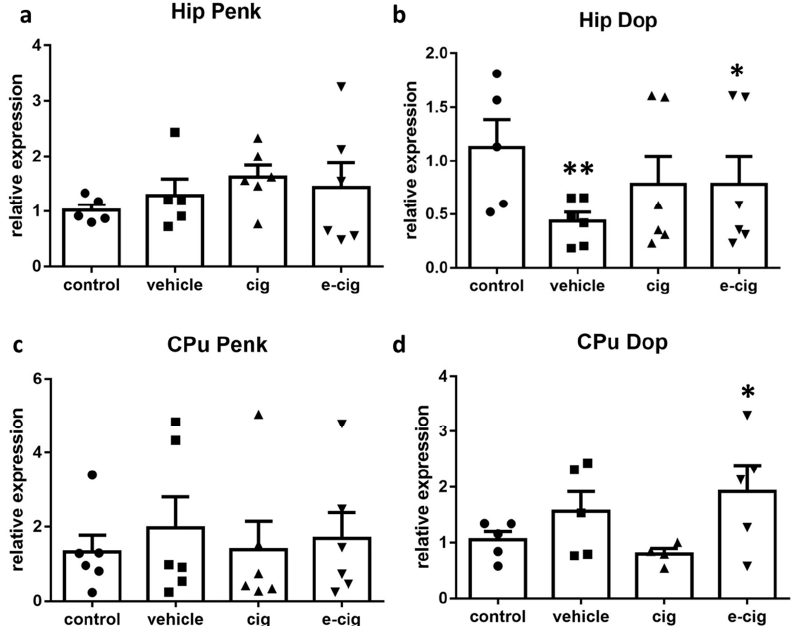
Figure 5. Relative mRNA levels of Penk ( a , c ) or enkephalin receptor Dop ( b , d ) after e-cigarette (e-cig, downward triangle) or cigarette (cig, upward triangle) exposure with respect to exposure to air (control, circle) or an e-cigarette administration vehicle (vehicle, square). The results displayed in panels a and b were obtained in the hippocampus, while panels c and d show the results of the CPu. The mice were exposed to cigarettes or e-cigarettes for 7 weeks, followed by a 60-day withdrawal. n = 4–6 for each group. **: p < 0.01, *: p < 0.05 in the Planned Comparison vs. control. Hip: hippocampus; CPu: caudate-putamen.